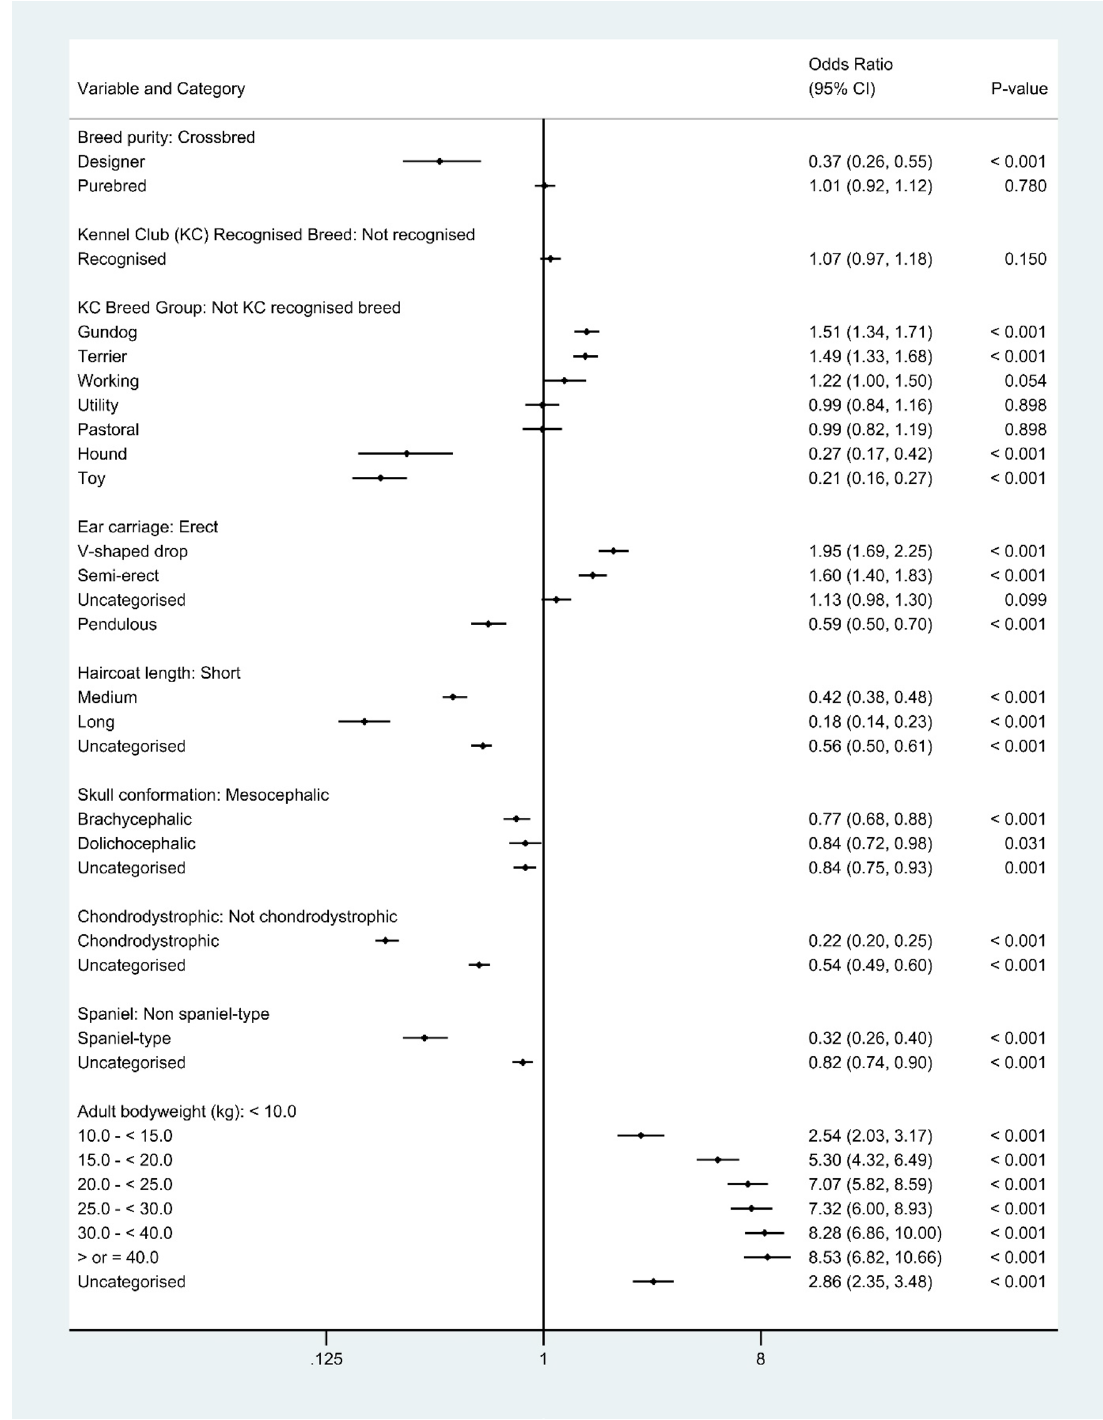
Figure 3. Results for risk factors that directly replaced the breed variable in the final breed-focused mixed effects multivariable logistic regression model (along with age, bodyweight relative to breed-sex mean, sex- neuter and insurance status). These results report associations between these risk factors and aural haematoma in dogs under primary veterinary care in the VetCompass™ Programme in the UK. Clinic attended was included as a random effect. *CI confidence